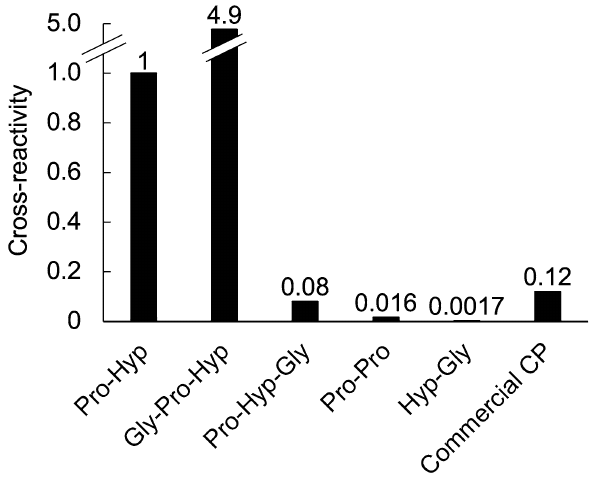
Figure 1. Cross-reactivity of anti-ACOP antibody to five collagen-derived peptides. Data are presented as relative values per weight normalized to that of